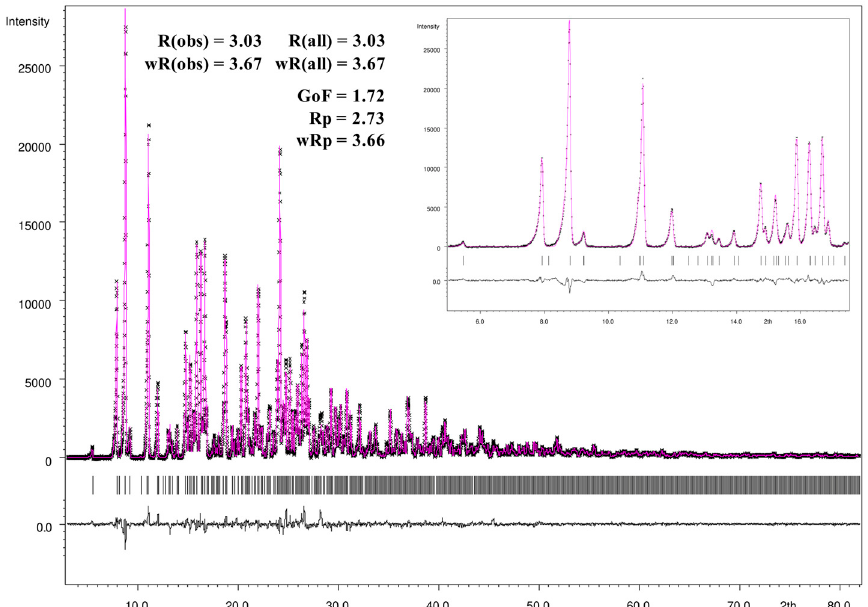
Figure 12. Observed (black crosses) and calculated (magenta line) X-ray powder diffraction pattern with difference profile of the Rietveld refinement (black line) as well as the positions of Bragg reflections (black bars) of a powder sample of the crystalline [Zn(C 12 H 8 N 2 ) 3 ]C 15 H 13 N 3 O 9 · 5H 2 O.